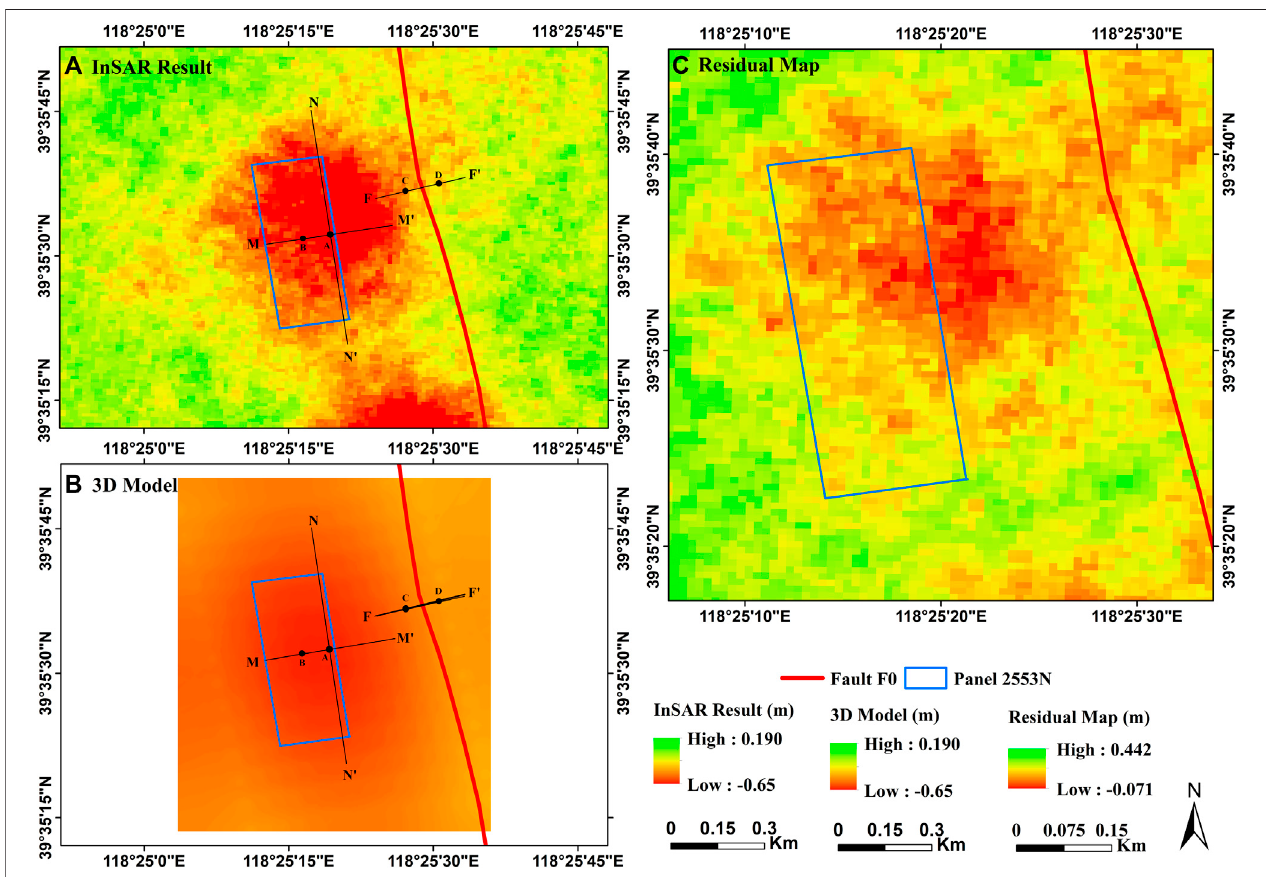
FIGURE 5 | Three-dimensional deformation generated by (A) InSAR result (B) 3D FDM model result (C) Residual result (InSAR — 3D FDM model).